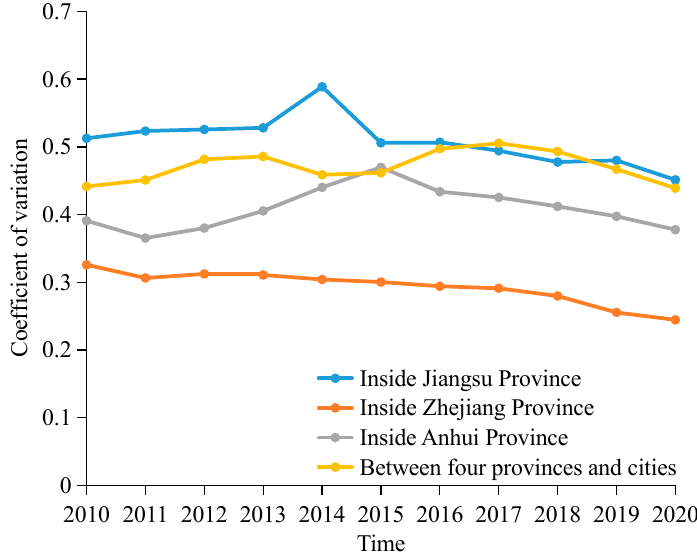
Figure 3. Coefficient of variation of the BPSL in the Yangtze River Delta provinces and cities, 2010– 2020.